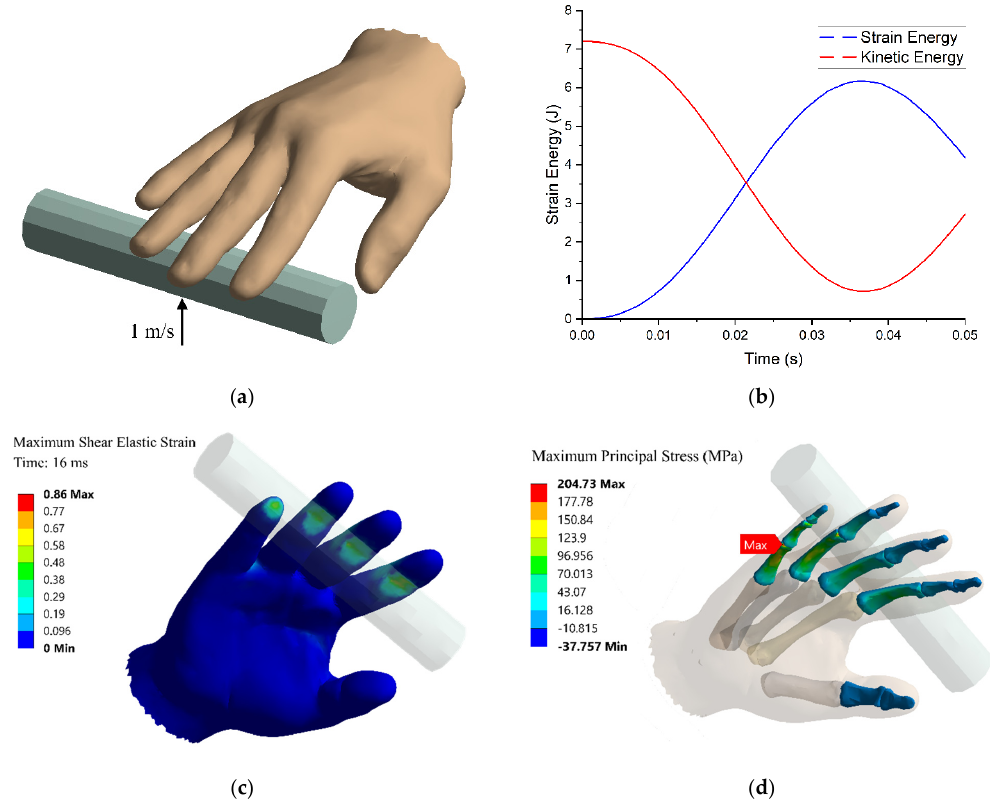
Figure 13. Impact of UR10 end effector at velocity of 1 m/s under hyperextension. ( a ) Impact Geometry, ( b ) Energy Transfer, ( c ) Shear Elastic Strain, and ( d ) Principal Stress.